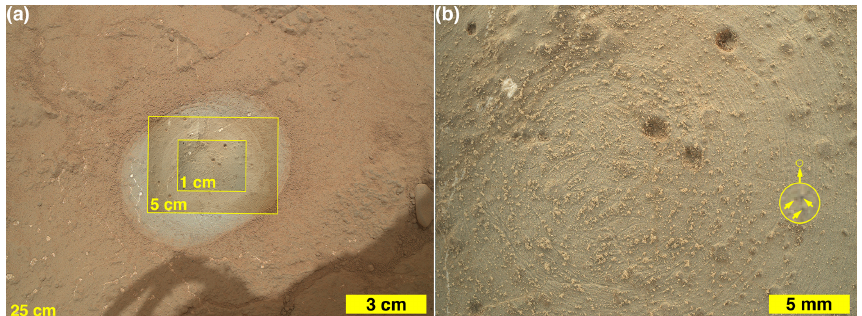
Figure 3. Sheepbed mudstone target, Wernecke, and example of nested MAHLI image acquisitions of increasing spatial resolution. (a) The three MAHLI images were acquired on sol 169 (26 January 2013) at working distances of 25, 5, and 1cm (indicated), yielding images at ∼ 100, ∼ 31, and ∼ 17µm per pixel, respectively. This is a composite of image 0169MH0002050010102201C00 and focus merge products 0169MH0001630000102236R00 and 0169MH0001630000102232R00. (b) View of Wernecke from 1cm standoff (16.6µmpixel − 1 ) in focus merge product 0169MH0001630000102232R00. Arrows inside circular inset point to dark gray grains in the rock. Because of their contrast relative to the bulk, lighter gray matrix, the darker grains provide a constraint on the mudstone particle size; they can be no larger than ∼ 34µm and no smaller than ∼ 17µm.